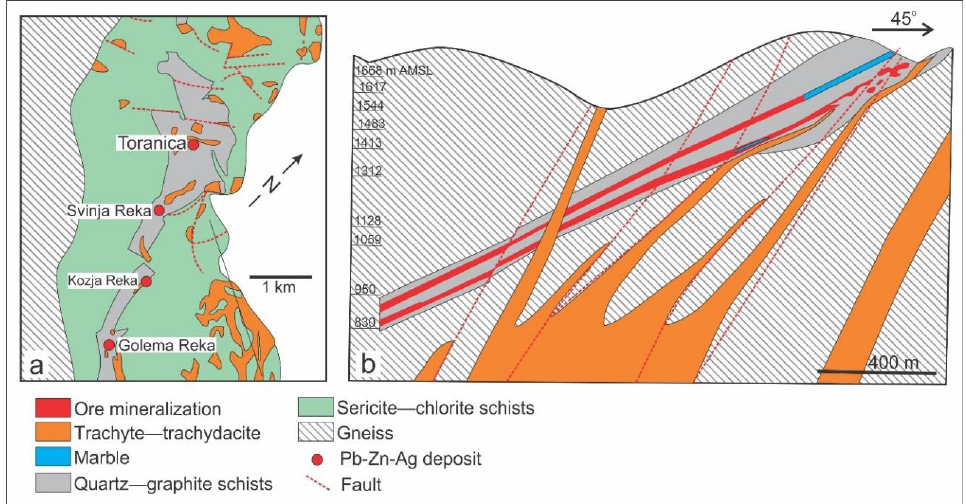
Figure 2. ( a ) Geologic map of the Sasa Pb-Zn-Ag skarn deposit area; ( b ) Longitudinal section through the Svinja Reka locality (from [39]). Abbreviation: AMSL — above mean sea level.